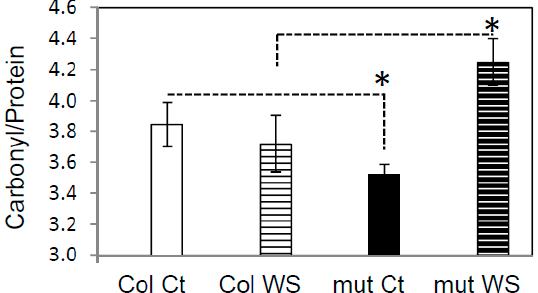
Figure 3. Protein carbonylation levels in wild-type (WT) and trxy1y2 mutant leaves after 7 days of drought. Protein carbonyls were detected after dinitrophenyl hydrazine (DNPH) labeling and quantification. Ct: control (well watered); WS: water stress (7 days). For each genotype/condition, 4 samples from two independent experiments were analyzed. Data correspond to molar carbonyl/protein ratios, means +/ − SD ( n = 4). Samples significantly different ( p < 0.05) are indicated by an asterisk (*).